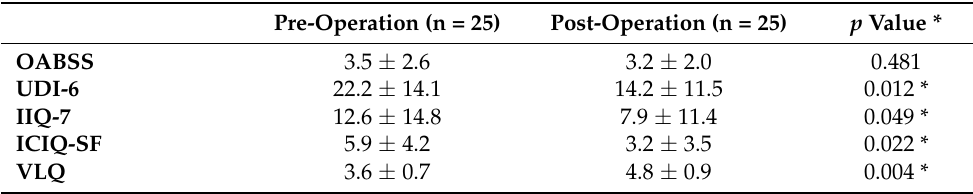
Table 2. Questionnaire results at baseline and 6 months